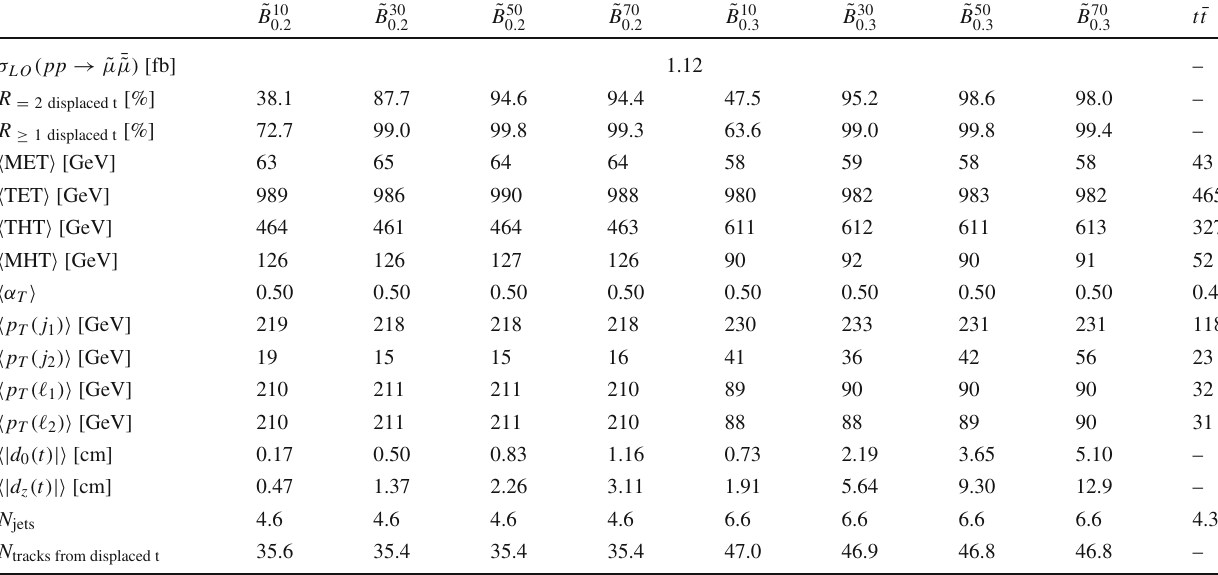
Table 3 Mean values of some observables and number of events with top quarks decaying in the tracker volume for the eight benchmarks in the bino ˜ B case. We remind that R ≥ 1 displaced t corresponds to the number of events with at least one top quark decaying in the tracker